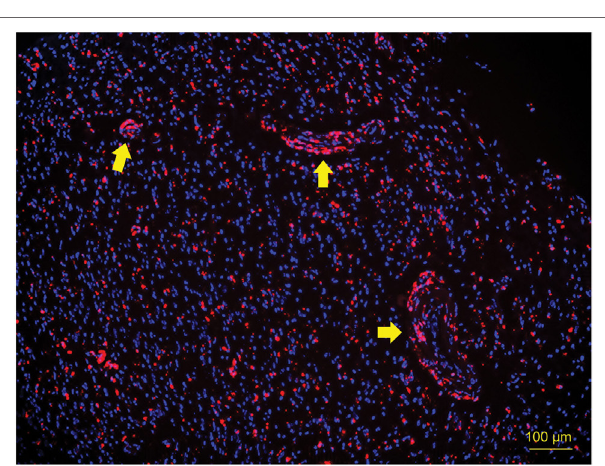
FigUre 4 | Fluorescence microscopy image of a 10-µm cryosection of the CE region. Tumor cell nuclei were stained with DAPI. Red fluorescence above 600 nm was observed in the cytoplasm of each tumor cell (excitation wavelength 390–410 nm), indicating that TS was incorporated into the tumor cells. Fluorescence was notably distinguishable along vascular endothelium (arrows). CE, contrast-enhanced; TS, talaporfin sodium.